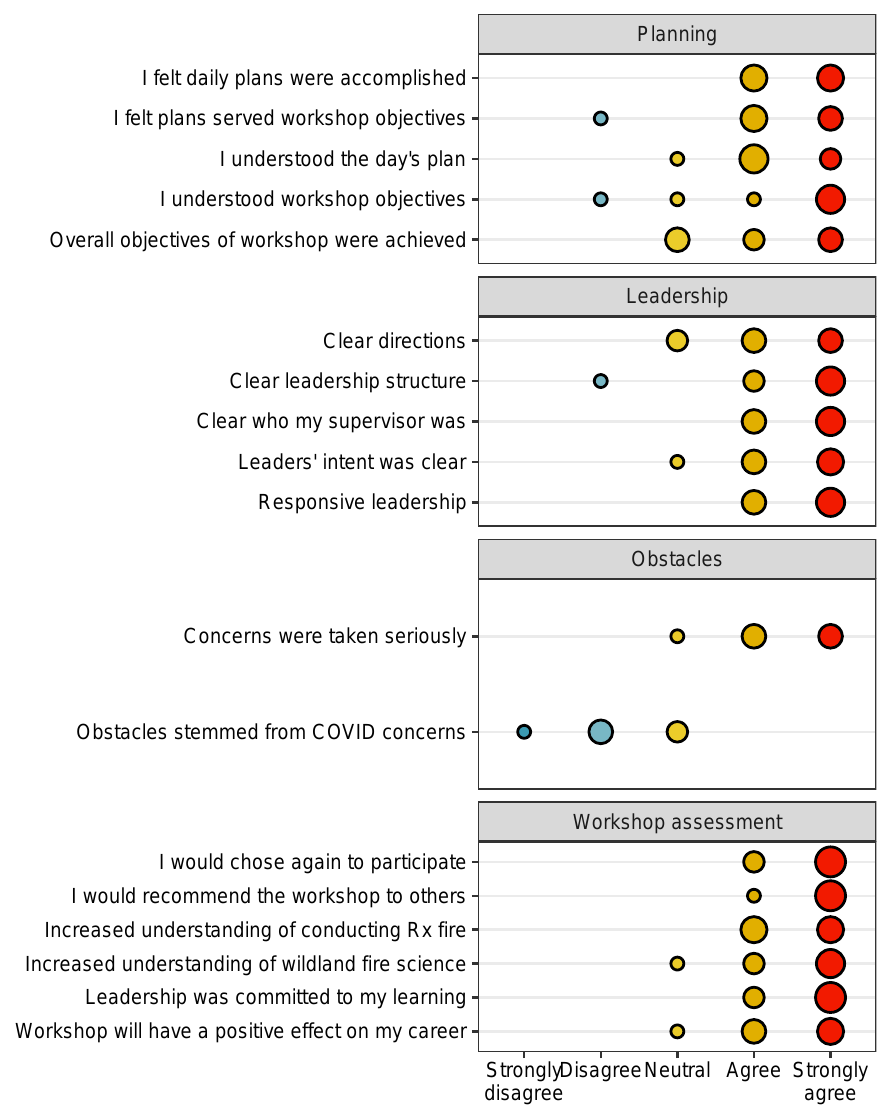
Figure 10. Responses from Likert-style questions in the workshop evaluation completed by 8 of 10